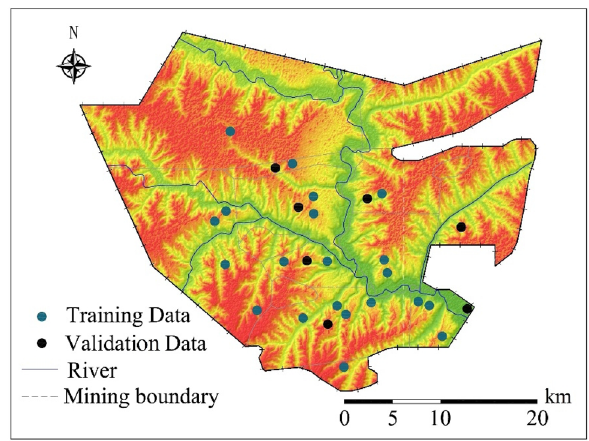
Fig. 1 Location of the study area and distribution of the WFFZ height